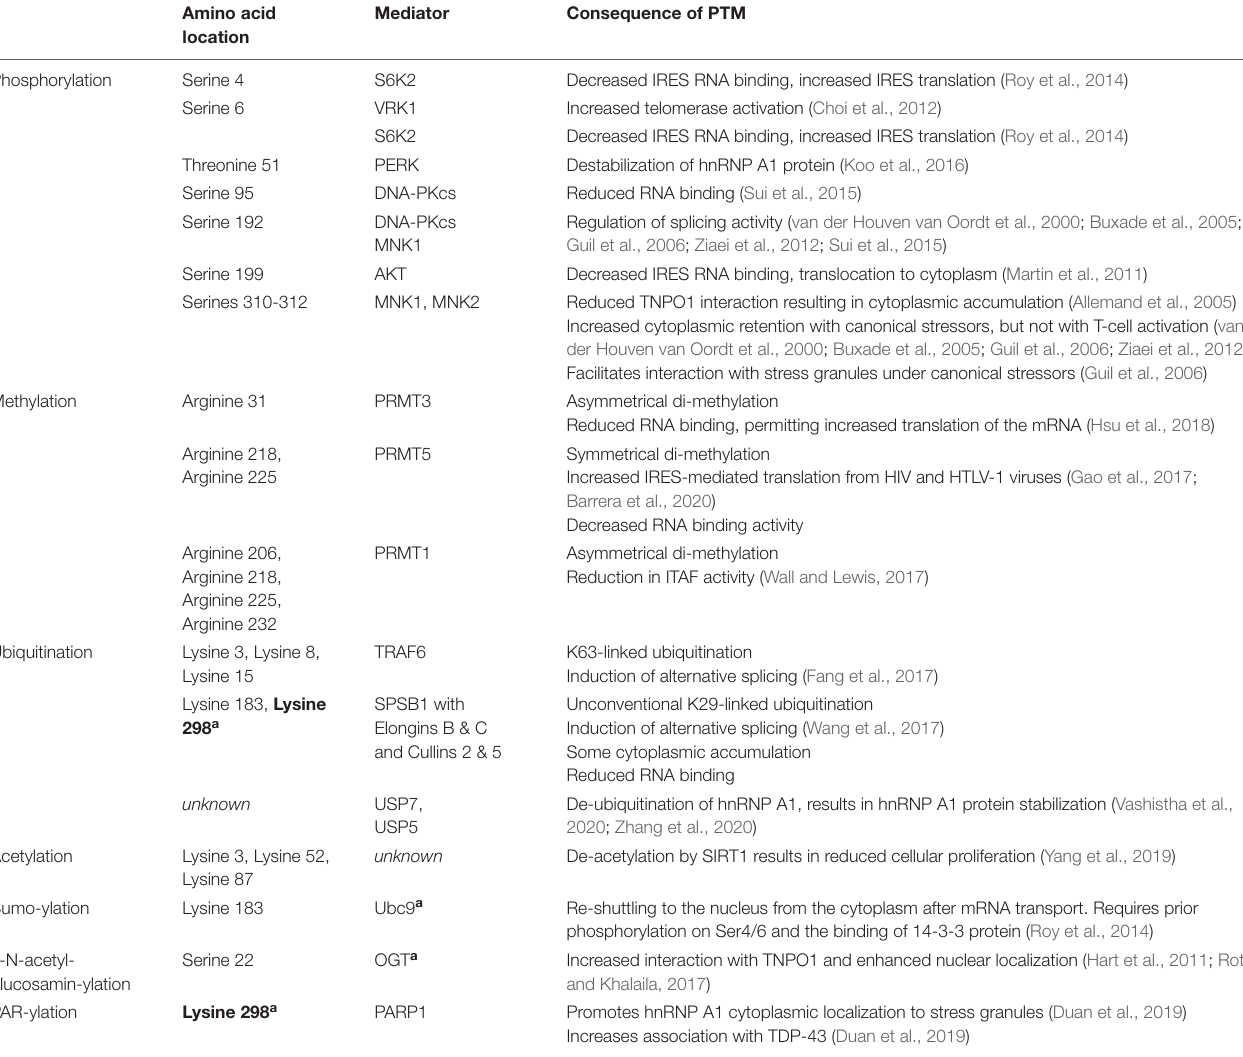
TABLE 1 | Post-translational modifications of hnRNP